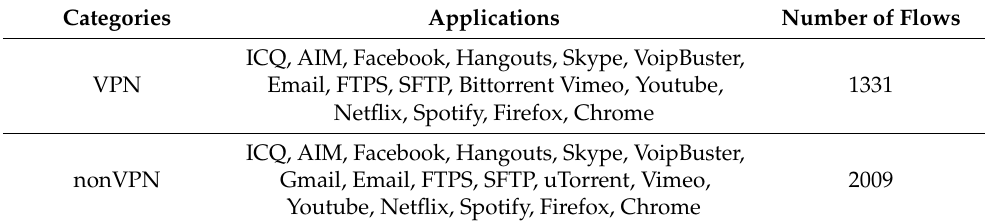
Table 3. ISCX VPN-nonVPN